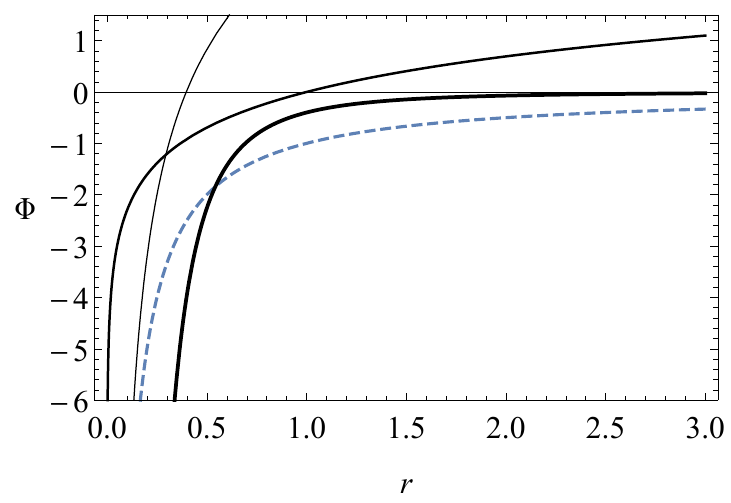
Figure 1 . Gravitational potential in d = 3 spatial dimensions for a point-wise source in the theory with weighted derivatives. Dashed curve: Einstein-theory limit (A.23) (valid for r (cid:28) r curves of increasing thickness: approximation (4.40) with small fractional correction with α = 1 . 5 (valid for r (cid:28) r ), logarithmic potential (4.34) (valid for α = 2 / 3 and r (cid:28) r ∗ fractional limit (4.33) with α = 1 . 5 (valid for r (cid:29) r